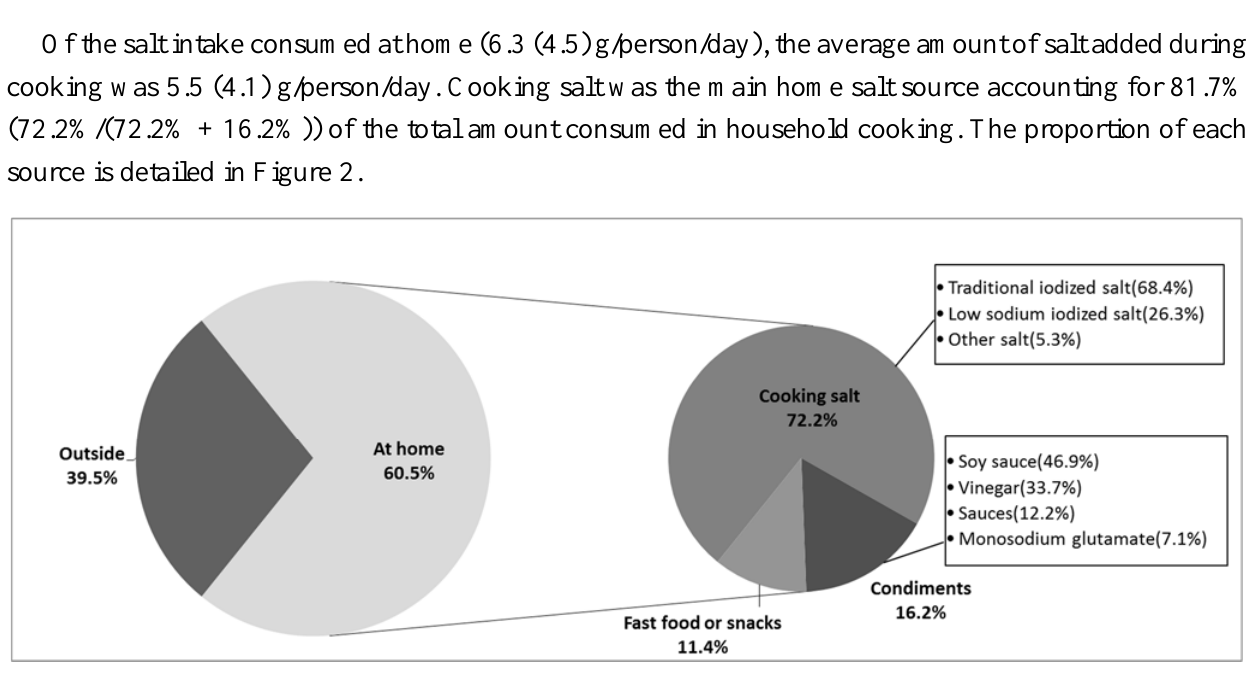
Figure 2. Sources of dietary salt